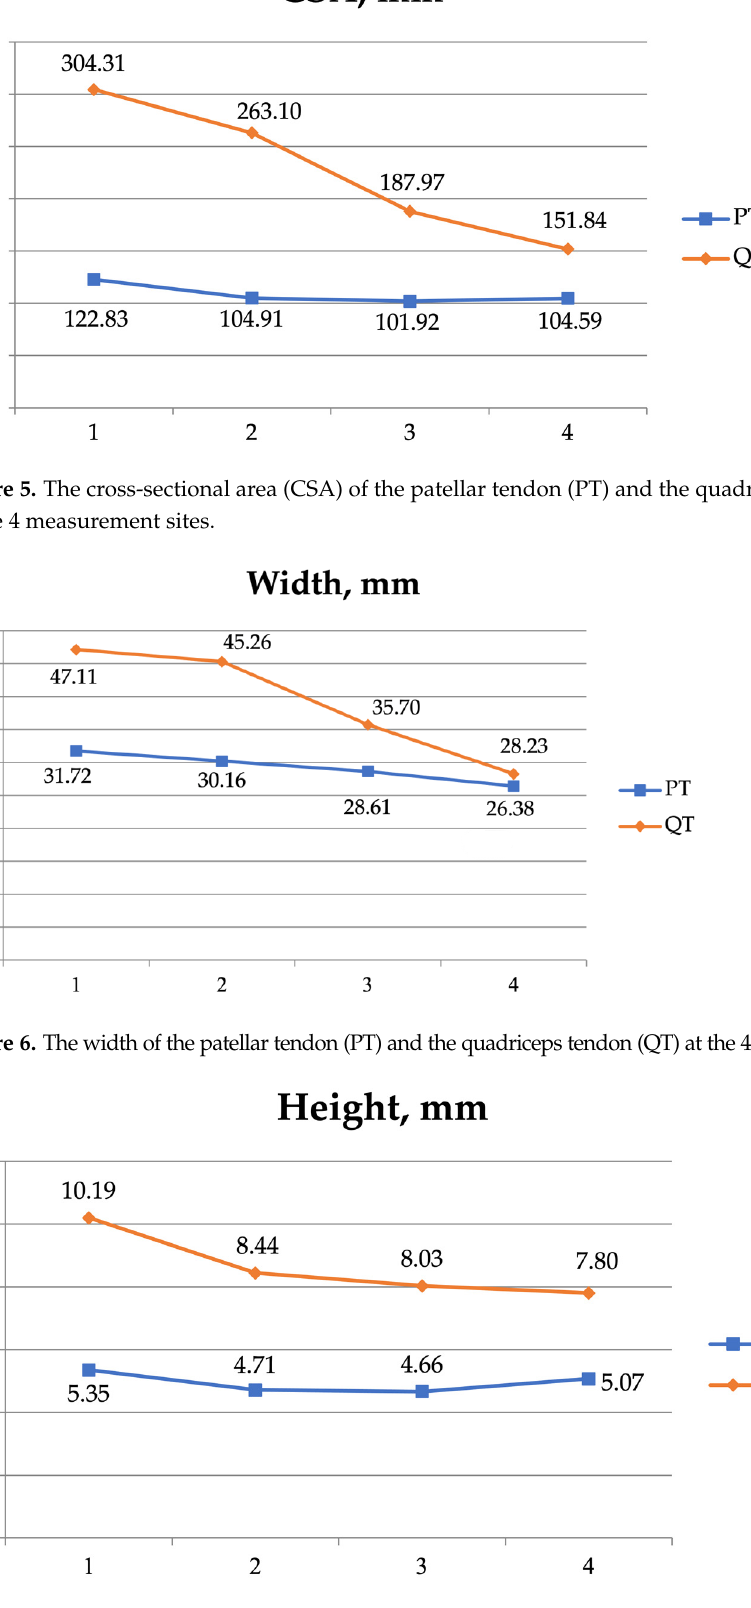
Figure 7. The anteroposterior diameter (height) of the patellar tendon (PT) and the quadriceps tendon (QT) at the 4 measurement sites. Table 5. Comparison between the patellar and the quadriceps tendons’ dimensions at four different measurement sites distal and proximal to the distal and the proximal patellar pole, accordingly. CSA, cross ‐ sectional area; SD, standard deviation. Variable